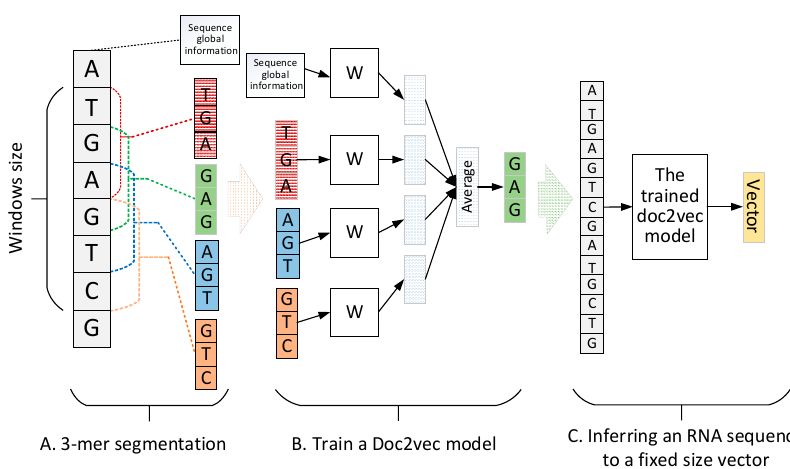
Figure 2. The training and inferring pipeline of doc2vec. ( A ) 3-mer segmentation process; ( B ) training process of a doc2vec model; ( C ) inferring process of doc2vec to encode a RNA sequence to a fixed-size vector.